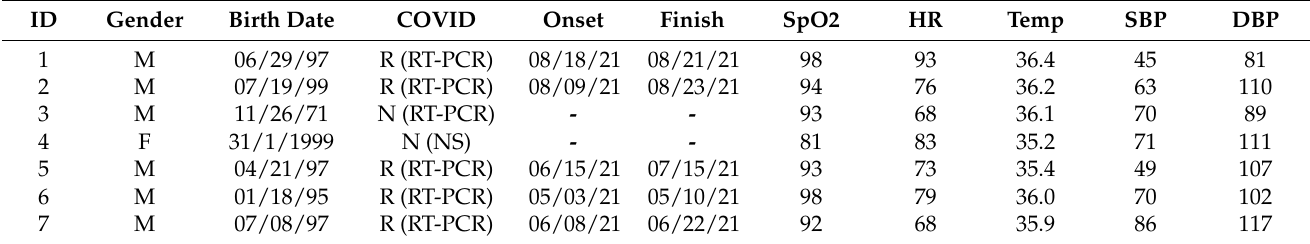
Table A1. Measurements and volunteers’ information taken during the IPMA’s evaluation by Ecuado- rian